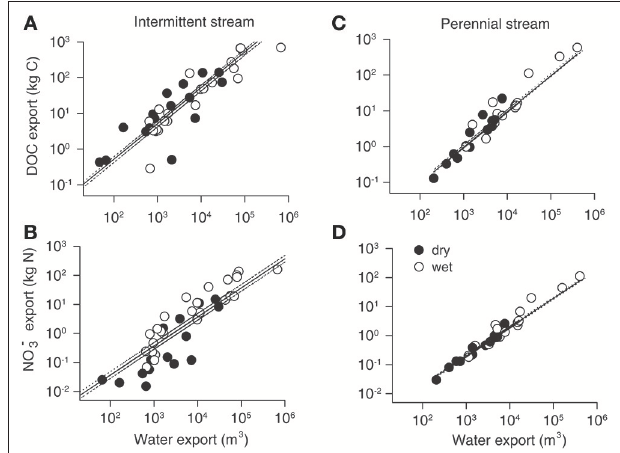
FIGURE 2 | Relationship between water export and solute export from the bottom sampling station for dissolved organic export (DOC) and nitrate (NO − 3 ) during individual storm events at the intermittent stream Fuirosos (A,B) and the perennial stream Font del Regàs (C,D) . Storms occurring during dry and wet periods are indicated with black and white circles, respectively. The solid line indicates the chemostatic scenario for which solute concentrations do not change with increasing discharge. The dotted lines indicate the upper and lower limit of the chemostatic scenario based on the 60th and 40th percentiles of calculated storm weighted concentrations (see text for